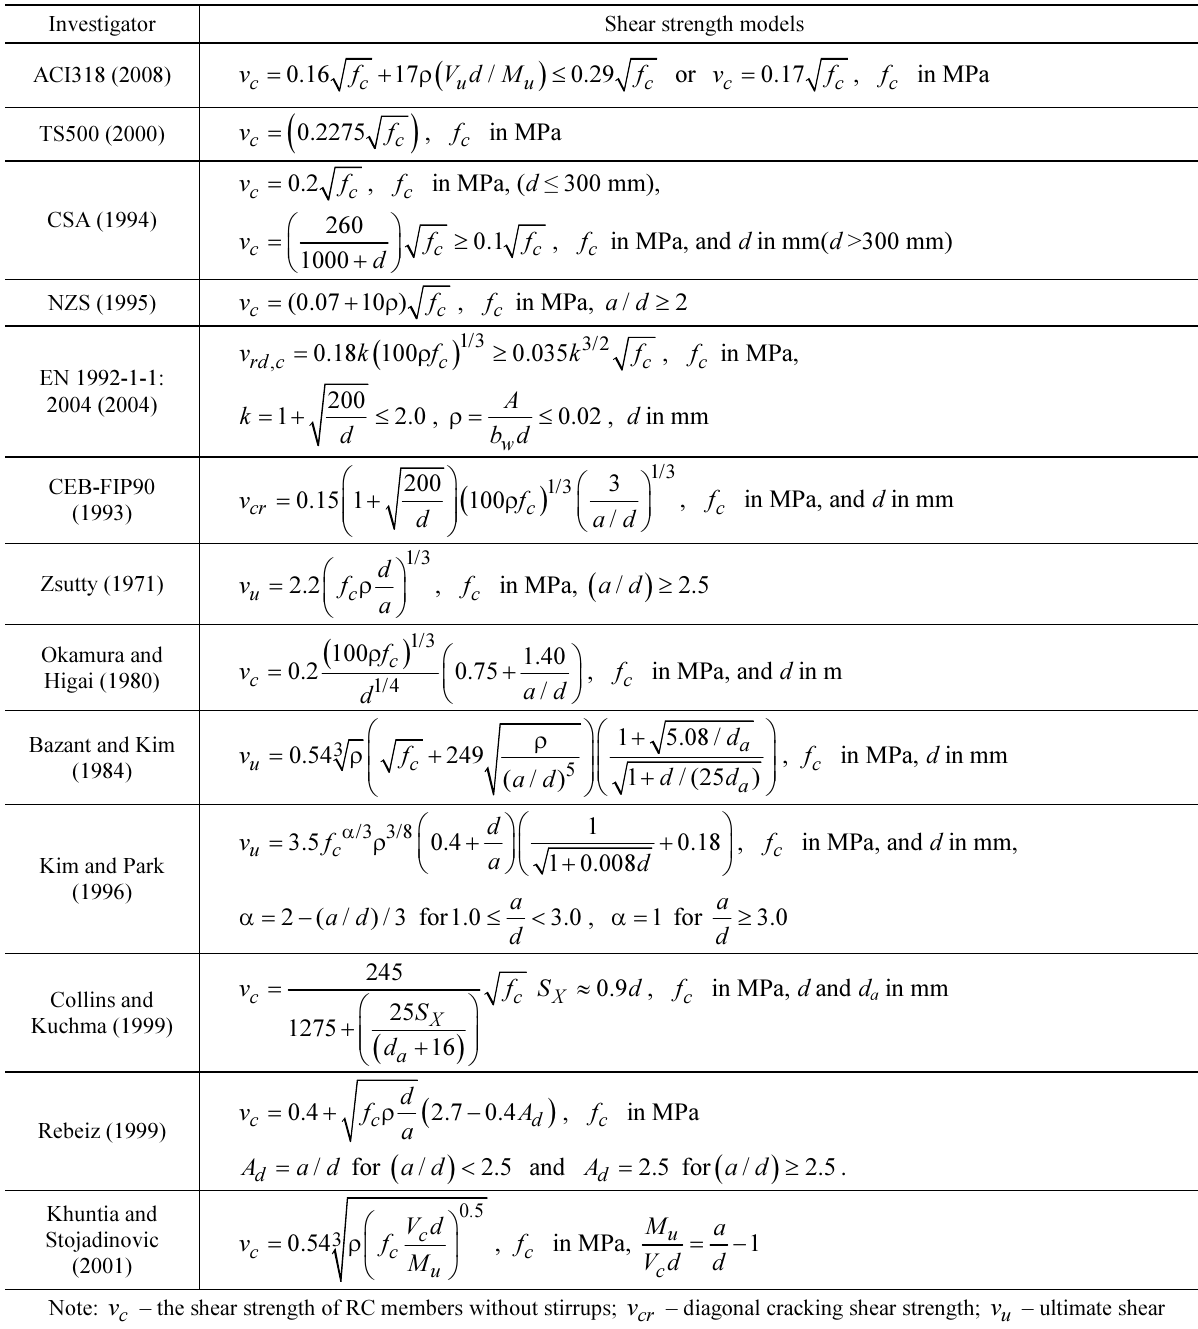
Table 1. Existing shear strength models for slender beams without stirrups